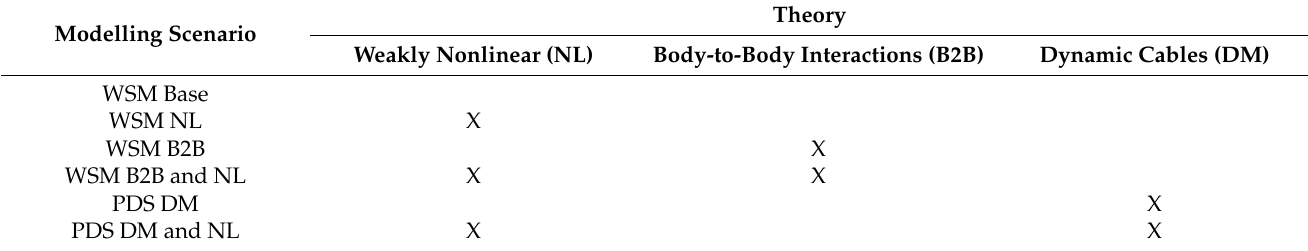
Table 2. Refined numerical theories scenarios (WSM: WEC-Sim, PDS: ProteusDS; X = Theory in-cluded). Modelling